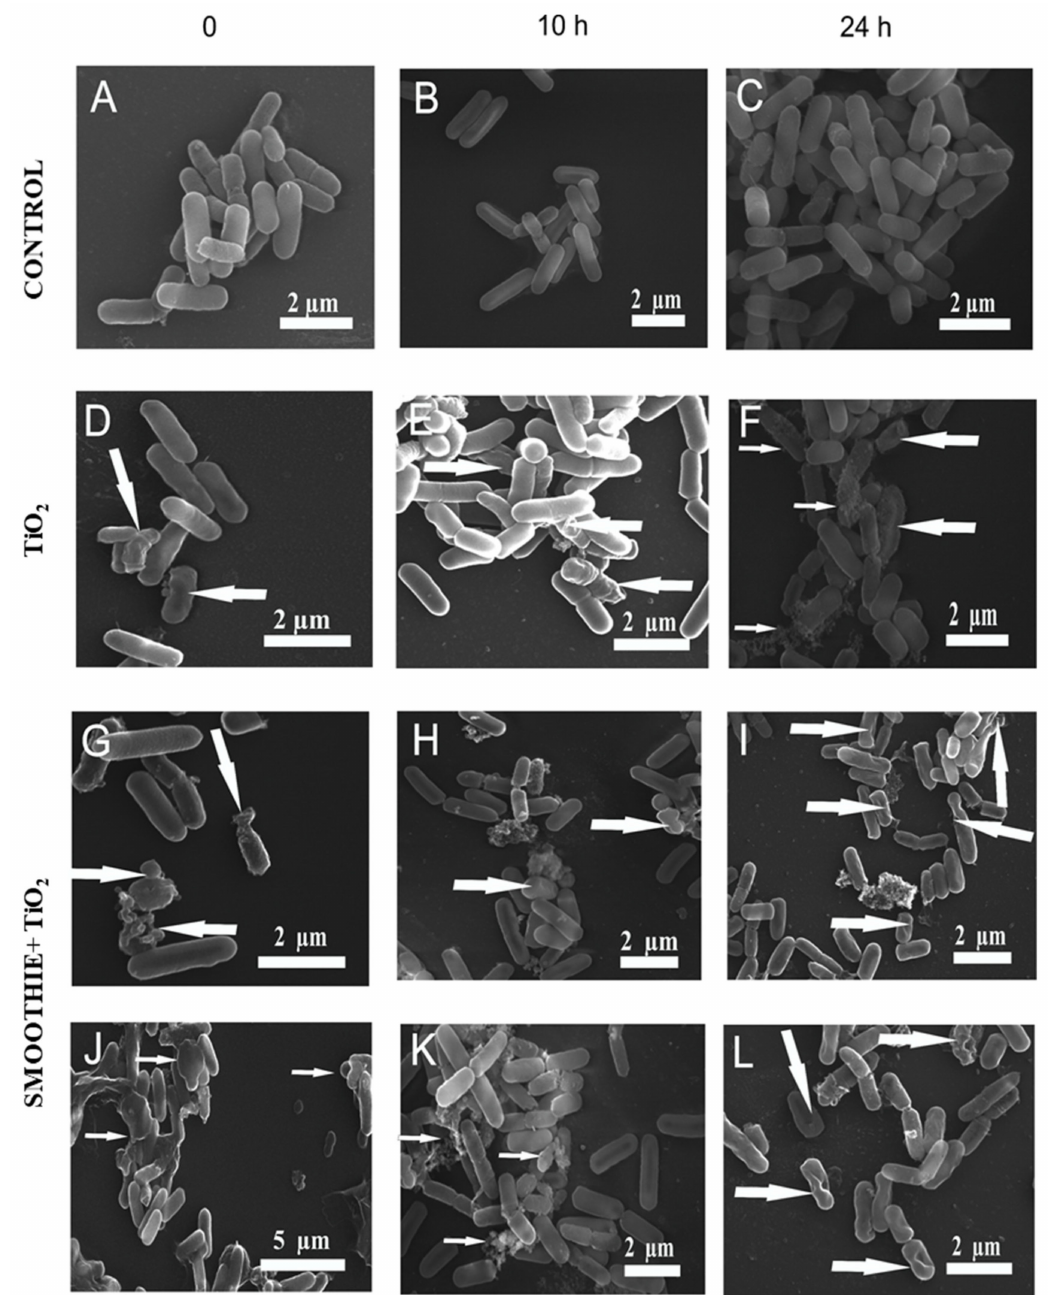
Figure 3. Scanning Electron Microscopy images of Lb. plantarum bacteria cells grown during in vitro digestions (0, 10, 24 h). ( A – C ): Control (bacteria only), ( D – F ): digestions with TiO 2 , ( G – L ): digestions with the smoothie and TiO 2 . Arrows indicate changes observed in cells or nanoparticles. Arrows indicate the deformation of cells or nanoparticles attached to cell